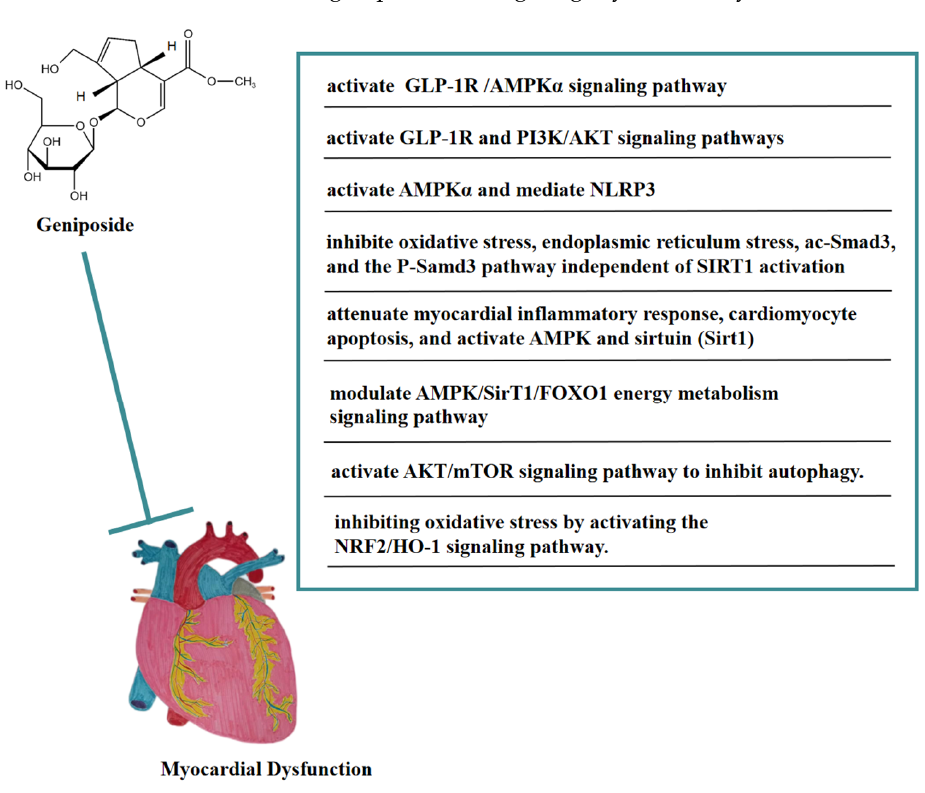
Figure 6. A summary of mechanisms of geniposide on myocardial